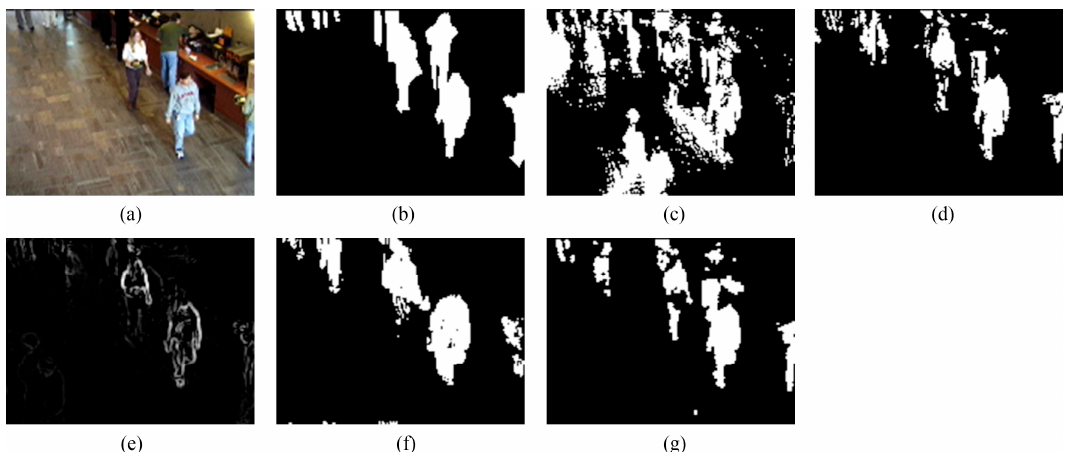
Figure 7. Detection results of the 10th frame of AP96 (Frame 3409): ( a ) input frame; ( b ) ground-truth reference; ( c ) result of ViBe; ( d ) result of PCP; ( e ) result of TD-2DDFT; ( f ) result of TD-2DUWT; ( g ) result of TD-3DDWT.